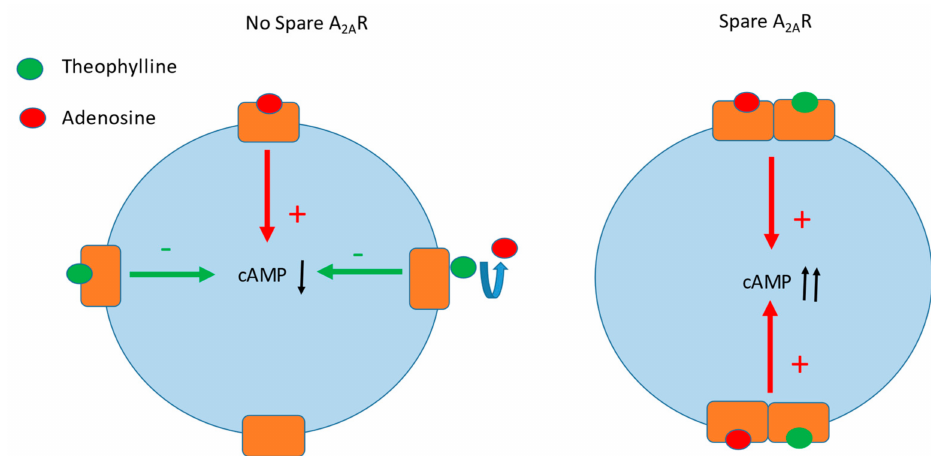
Figure 4. In the absence of an adenosine receptor reserve (spare, left panel), theophylline inhibits the production of cAMP following the activation of A 2A R by adenosine in a dose-dependent manner. In the presence of spare ( right panel), the activation by adenosine of a small fraction of adenosine receptors leads to a maximal production of cAMP in target cells, rendering ineffective the inhibition of cAMP production by the antagonist